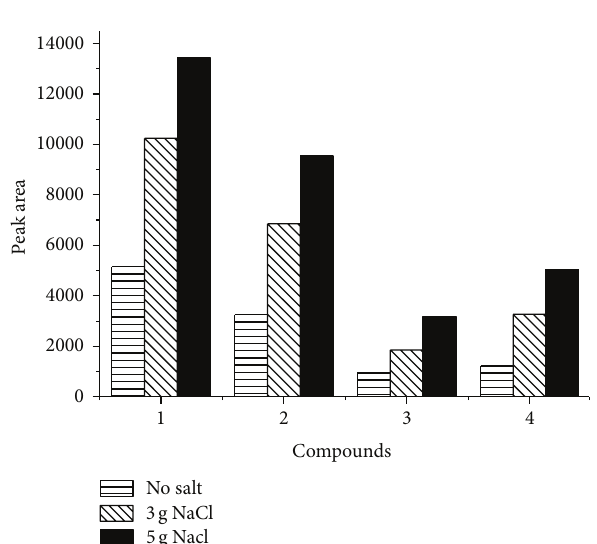
Figure 3: The extraction temperature profile for 4 representative compounds. Conditions: extraction time, 30 min; desorption time, 5 min; saturated out with NaCl; magnetic stirring. Peaks: 1, n C 17 - alkane; 2, pristine; 3, naphthalene; and 4, 5- 𝛼 -Androstane.